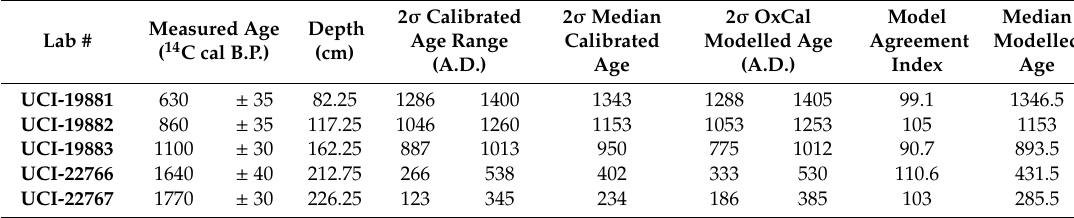
Table 1. Measured, calibrated and modelled 14 C ages from El